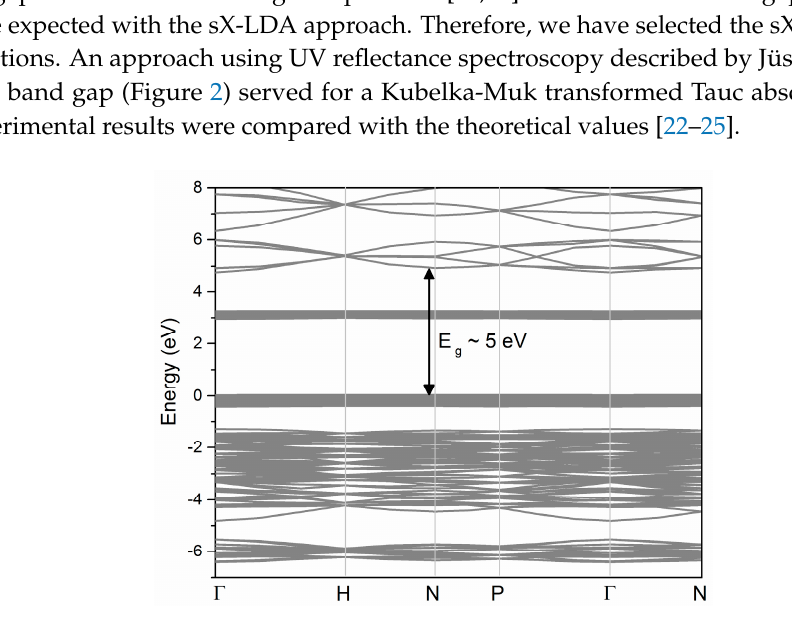
Figure 1. The calculated band structure of Gd 3 Li 3 Te 2 O 12 . sX-LDA calculated electronic bands are shown. The Fermi level is set to zero.